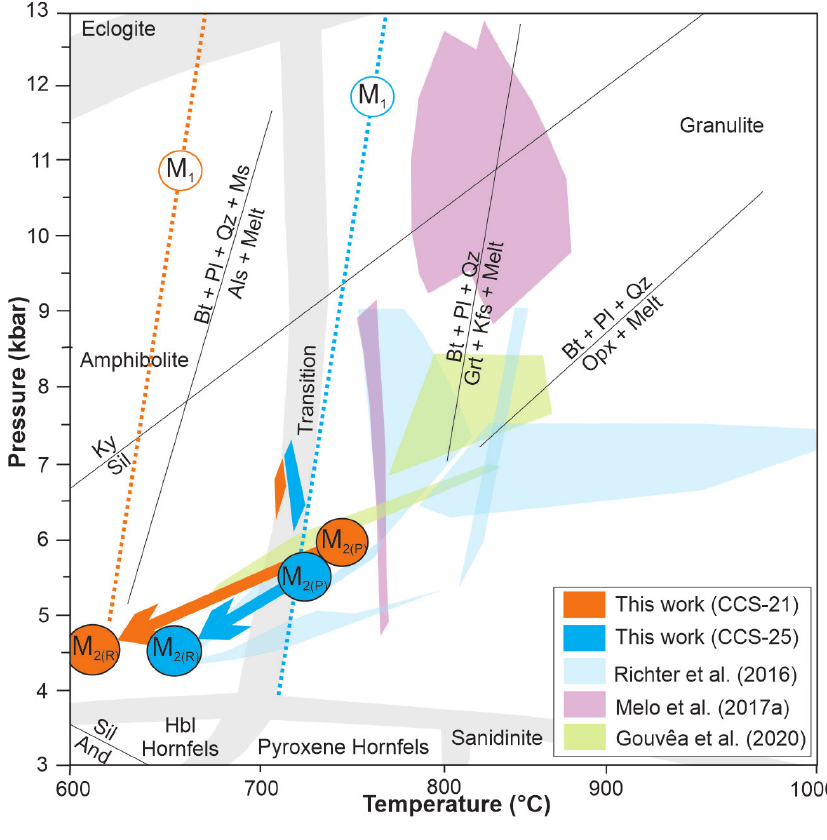
Figure 13. P–T path for collisional rocks from the Carlos Chagas